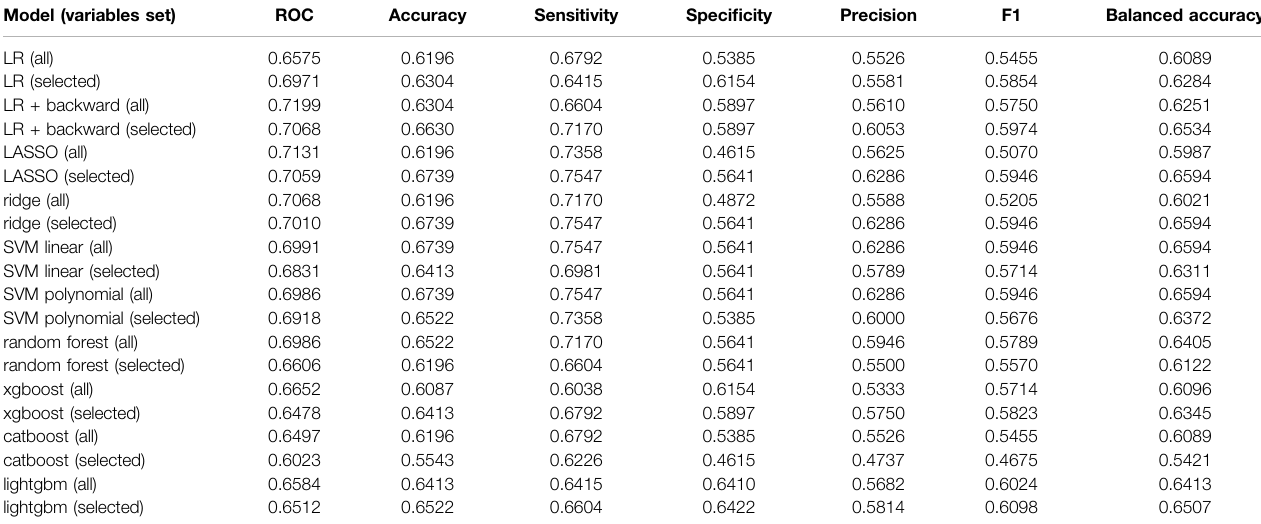
TABLE 2 | Summary of models ’ performance on a test sample. Model (variables set)